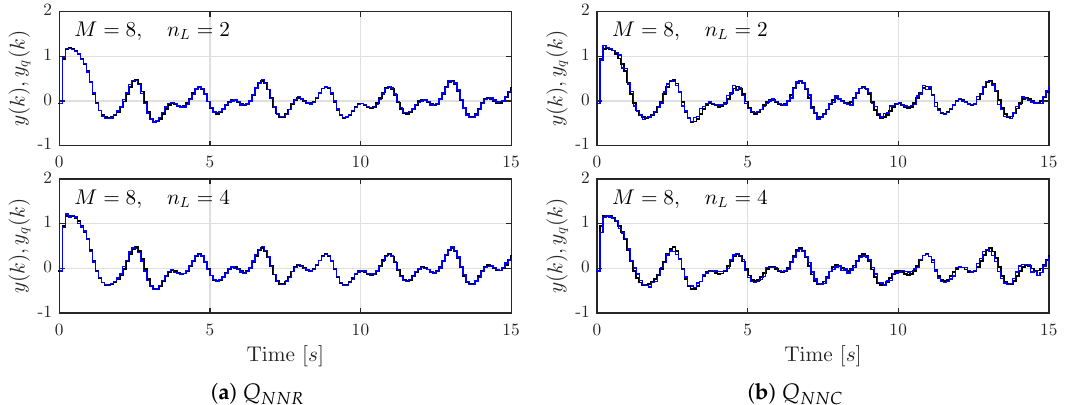
Figure 9. Output signals y q ( k ) (blue) and y ( k ) (black) resulting from applying u ( k ) to the error system with Q NN designed for M = 8, n L = 2 ( upper figure ) and n L = 4 ( lower figure ).